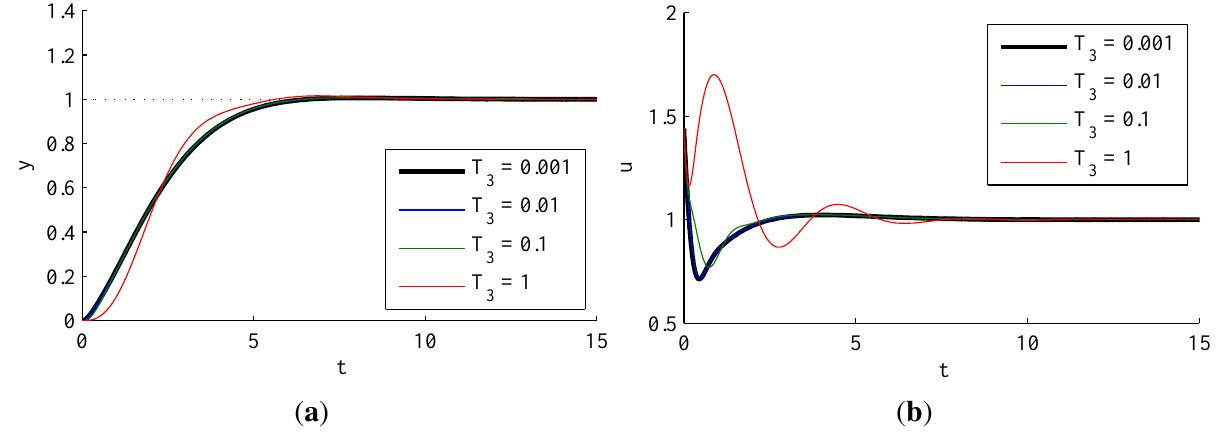
Figure 15. Experiment 3.2.5: effect of structural uncertainties on a second-order ADRC controlling a process with dominating second-order behavior ( K = 1, D = 1, T = 1) and higher-order dynamics caused by an unknown third pole at s = = 1, T = 5, s ESO = 5 = K s CL . ( a ) Variation of T b 0 settle T 2 · Controller output u for ( a